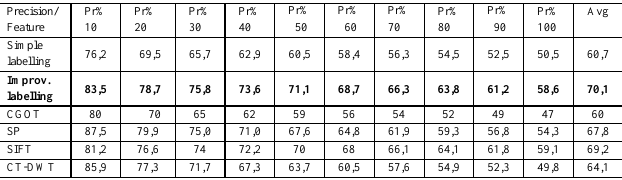
Table 5. Comparison using average precision values for each category for improved labelling using simple statistics.